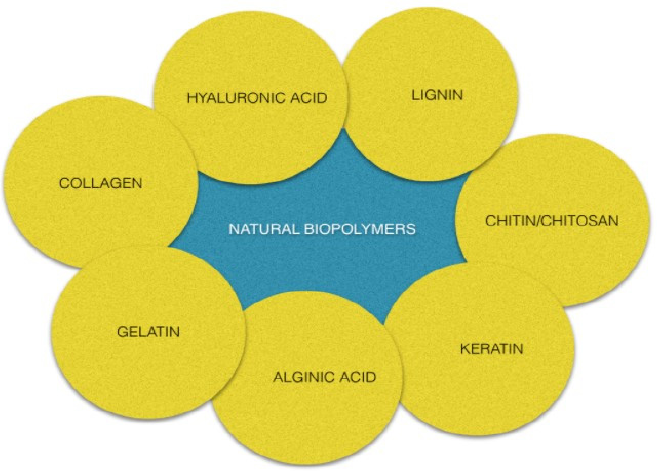
Figure 6. Some of the natural polymers used to make Nanocomposites and wound dressings.